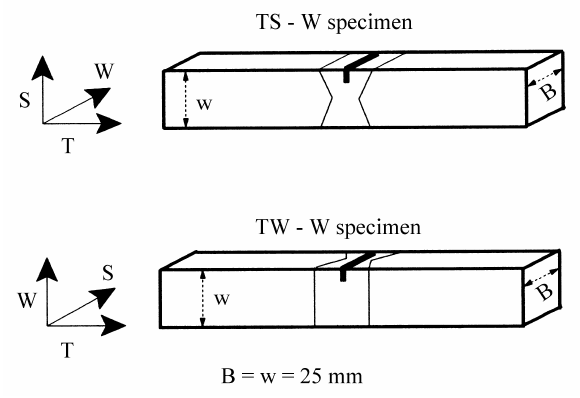
Figure 3. TS and TW geometries. Table 2. Specimen dimensions, notch characteristics and type of electrode used as central